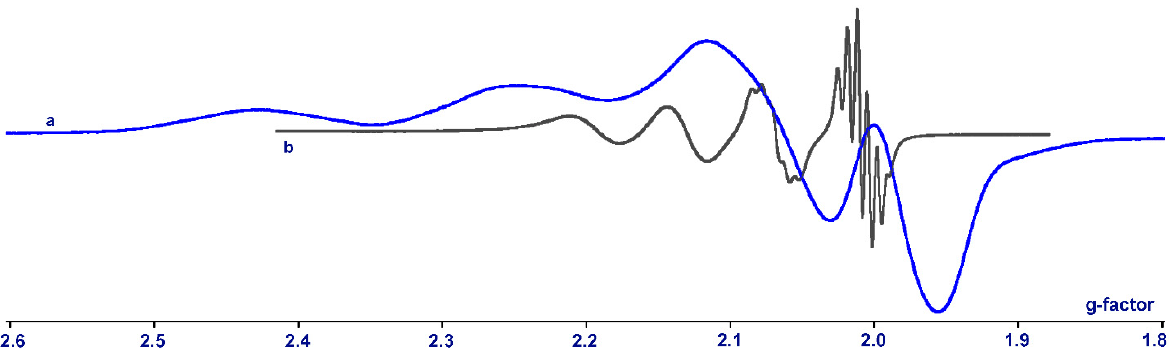
Figure 4. EPR spectra for complex 1 in solid state ( a ) and in CH 2 Cl 2 solution ( b ) at room tempera-